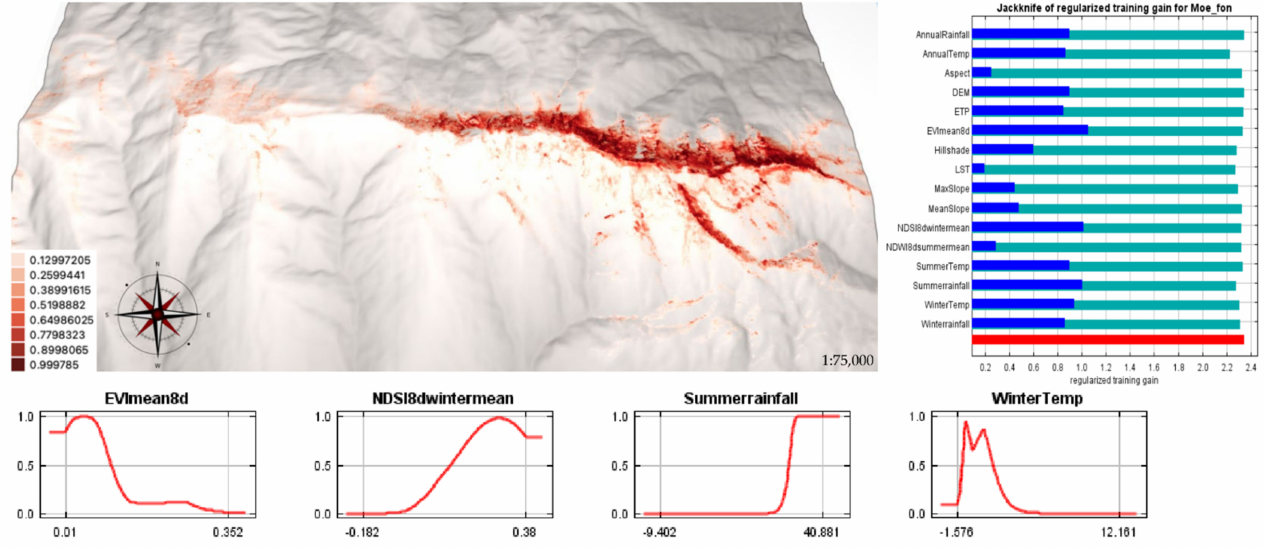
Figure 4. Current potential distribution model of Moehringia fontqueri for all occurrences throughout the distribution range. Regularized training gain values of the jackknife tests. Most explanatory variables (ASP: Summerrainfall (mm) AWT: WinterTemp ( ◦ C)).